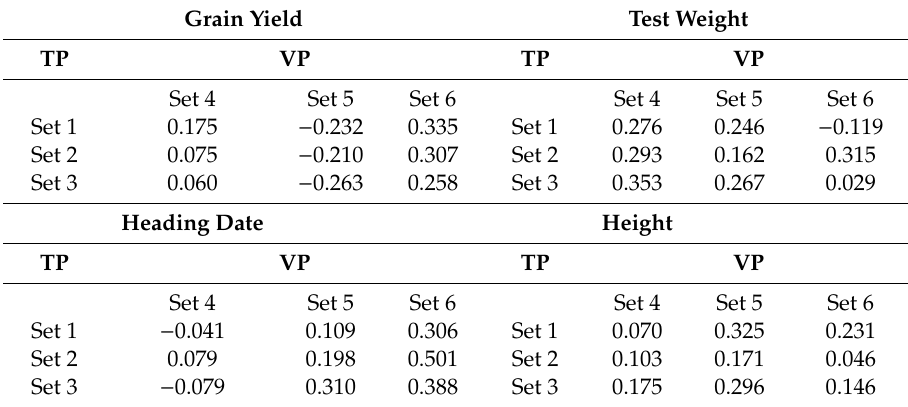
after 1 January) and height (cm) using advanced line training populations to predict preliminary line performance. TP = training population; VP = validation